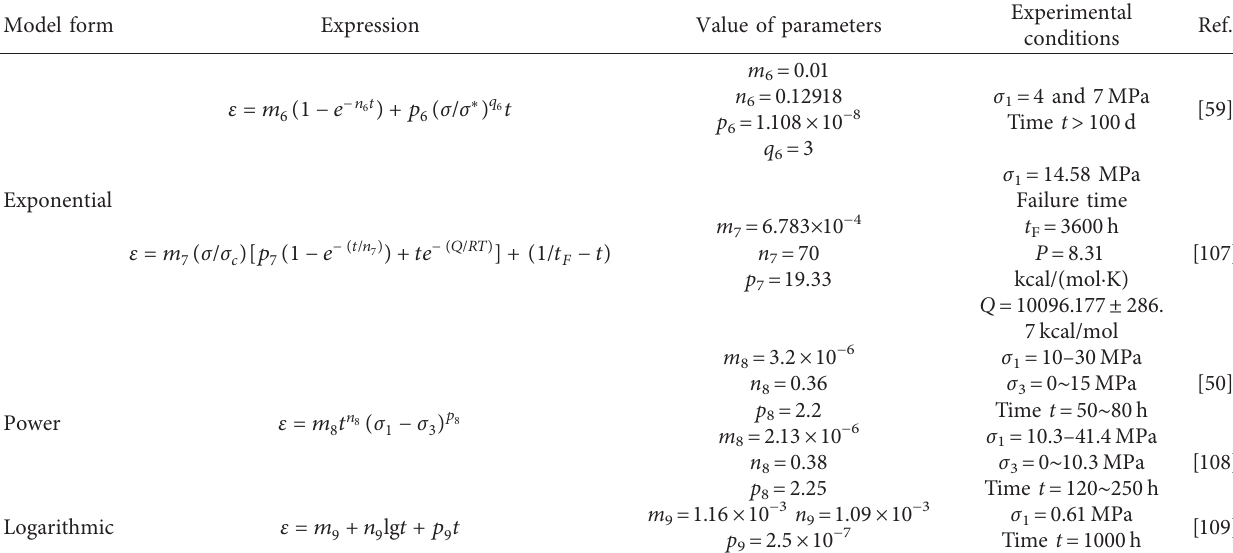
Figure 8: Variation law of AE time-space characteristics of salt rock with creep time: (a) 0 ∼ 30d; (b) 60 ∼ 66 d; (c) 66 ∼ 96 d; (d) 96 ∼ 136 d; (e) 136 ∼ 176d; (f) 220 ∼ 260 d; (g) 260 ∼ 300 d; (h) 260 ∼ 300d; (i) 300 ∼ 330 d; (j) 330 ∼ 359d [101]. Table 1: Common expressions of the empirical